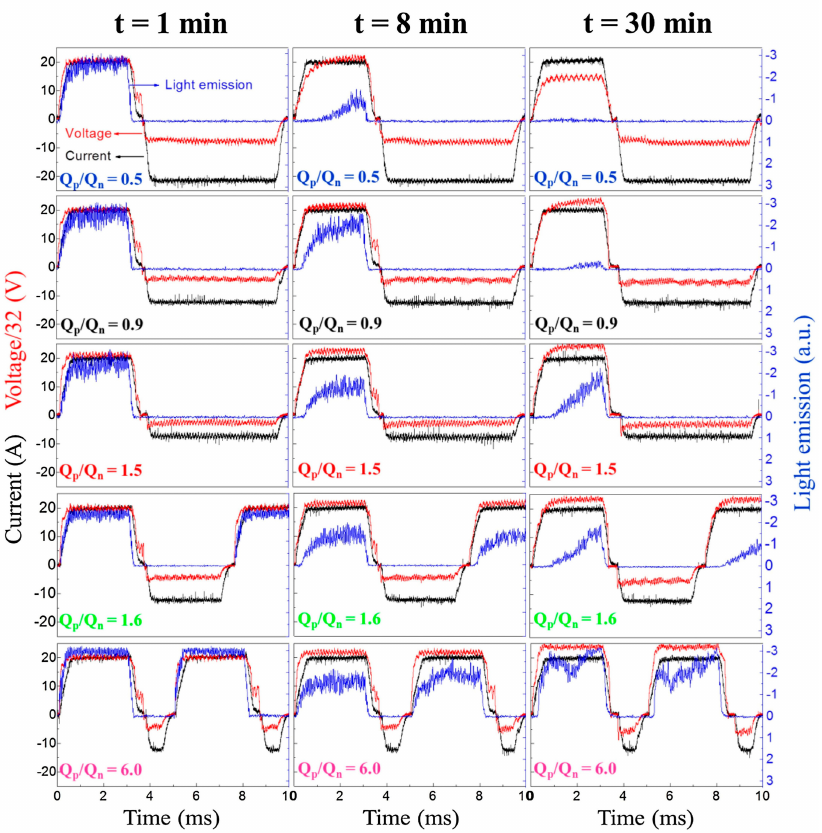
Figure 4. Influences of cathodic electricity decrease with increasing R pn ( Q p / Q n ), and increase with increasing time. Five PEOs have been operated with Q p / Q n = 0.5, 0.9, 1.5, 1.6, 6.0 using a bipolar pulse current, with the voltages, currents, light emissions measured at 1, 8, 30 min. The preceding cathodic pulse delays the microdischarge activity of its following anodic pulse